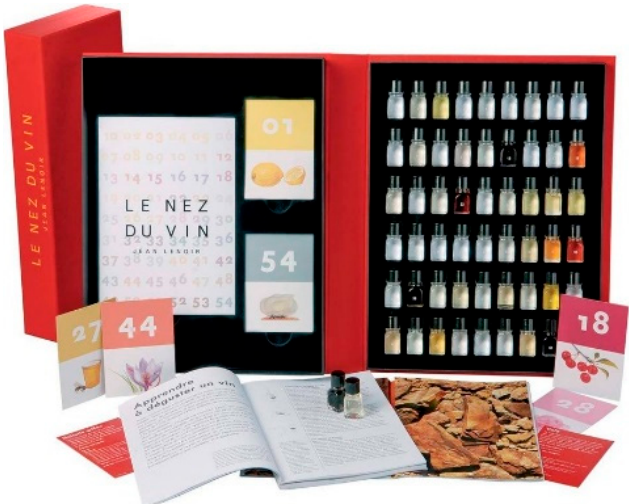
Figure 1. Le Nez by Vin aroma kit ® by Jean Lenoir. A complete perfume box to learn how to recognize odors and train the sense of smell. This set consists of 54 bottles with wine aromas.